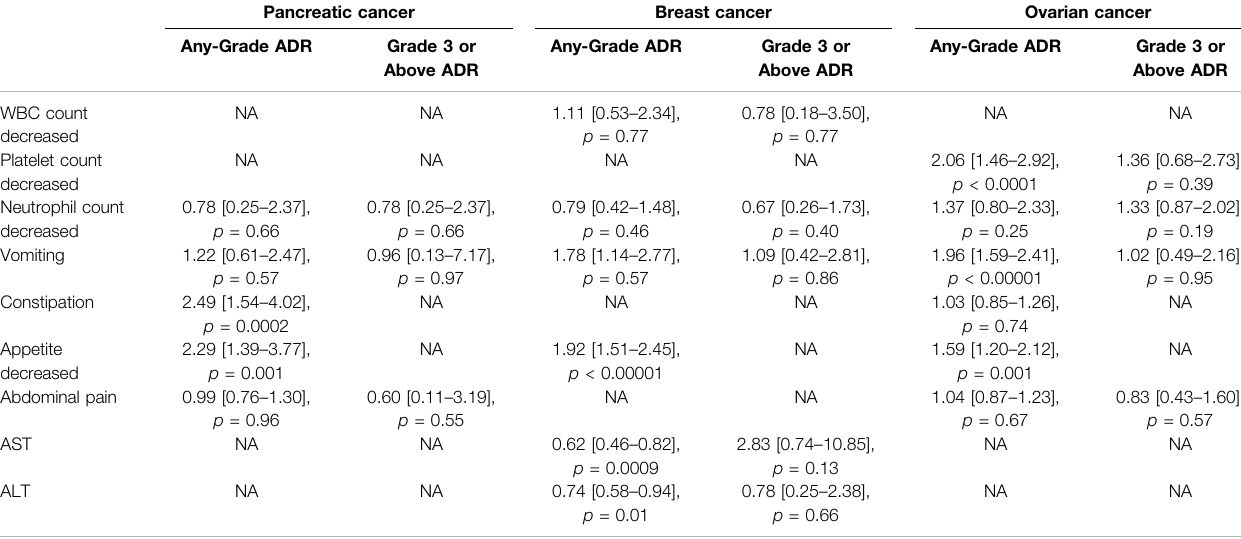
TABLE 2 | Meta-analysis of secondary adverse reactions of Olaparib for different